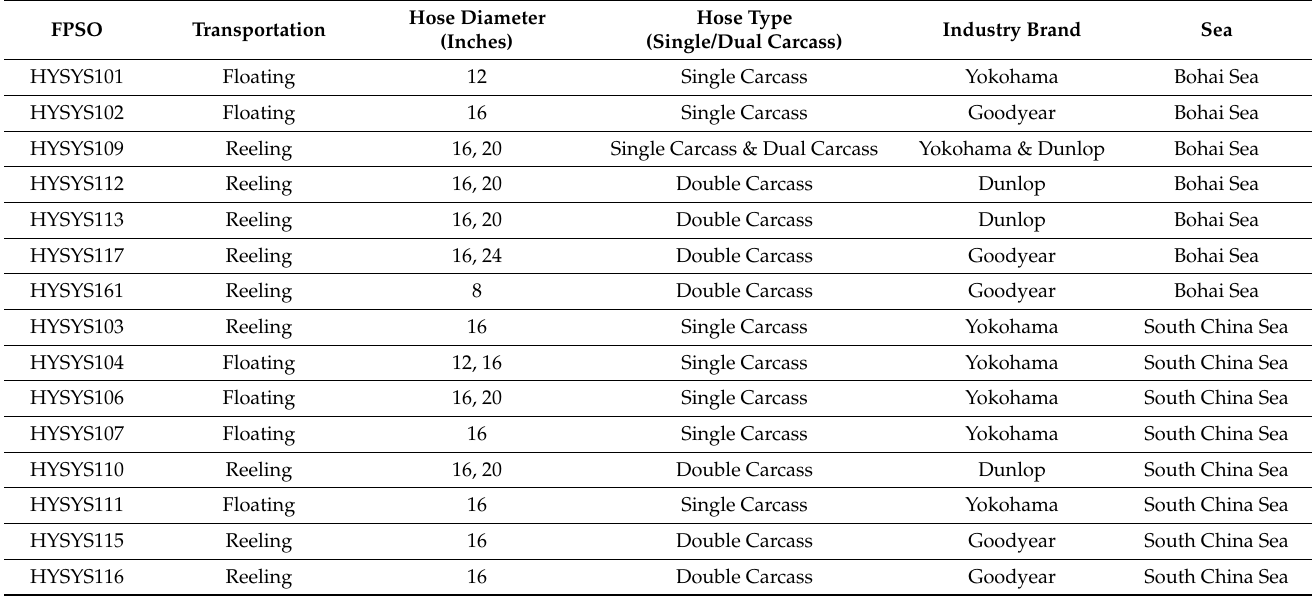
Table 2. Application of offshore hoses in Bohai Sea and South China